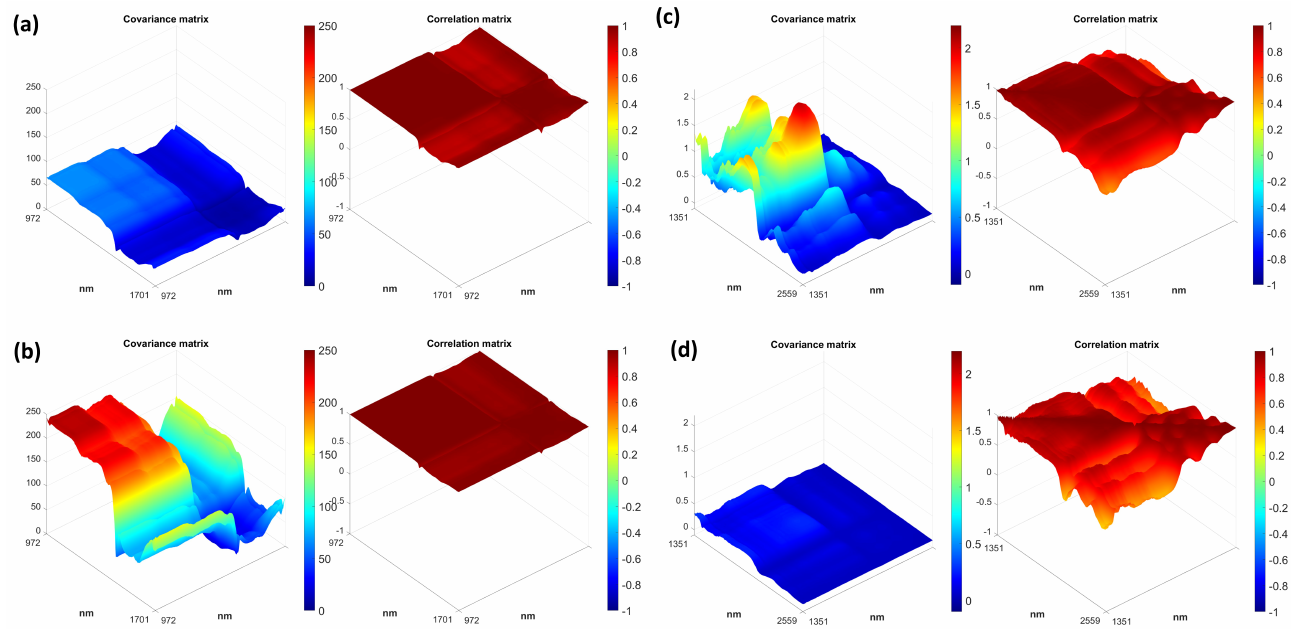
Figure 4. Measurement error covariance and correlation matrix for sugar lump spectra ( a ) and granulated sugar spectra ( b ) acquired with AvaSpec − Mini − NIR and for sugar lump spectra ( c ) and granulated sugar spectra( d ) acquired with NeoSpectra